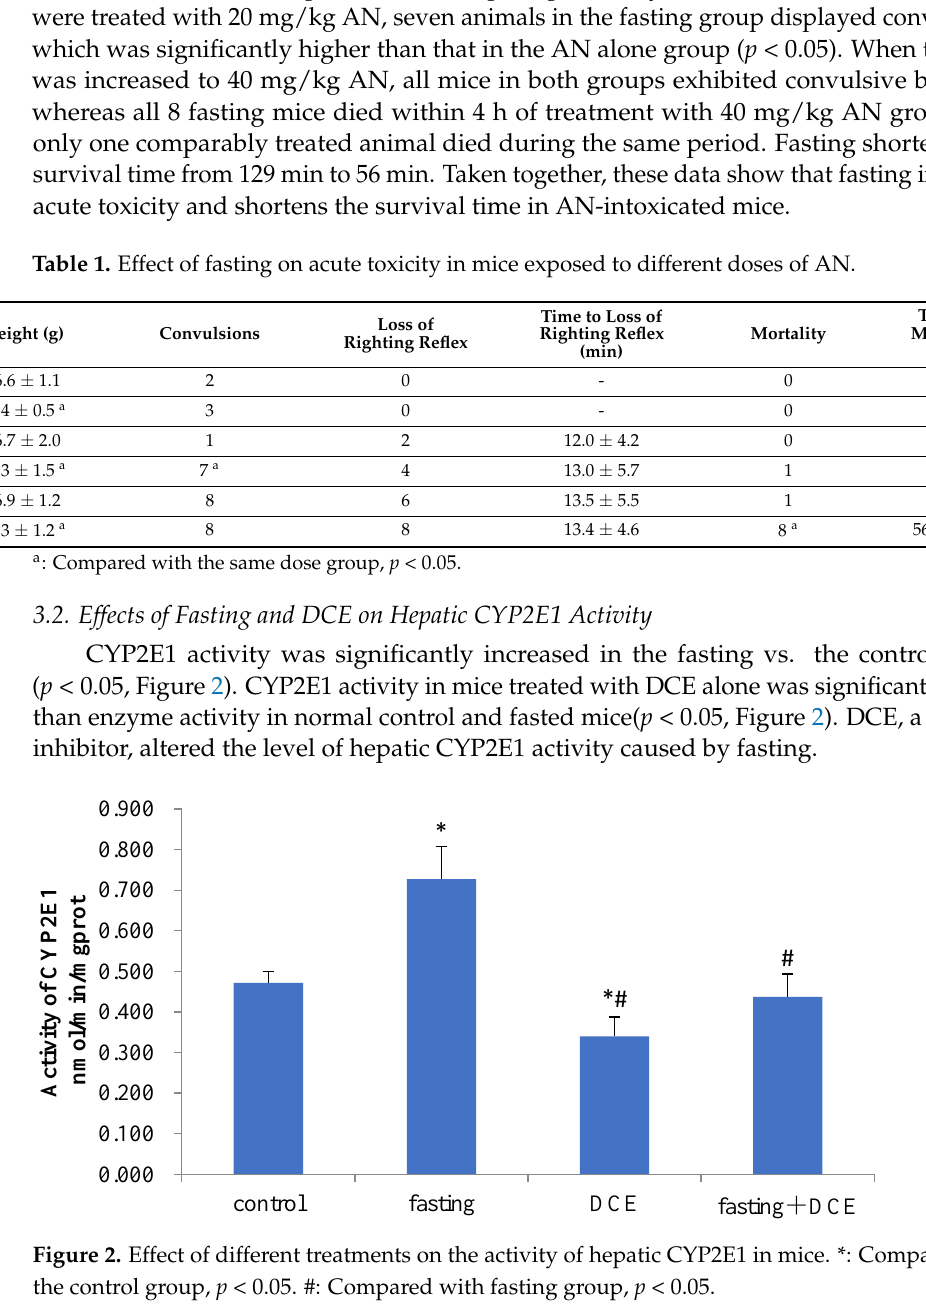
Table2. Effects of fasting and DCE on acute toxicity in mice exposed to 40 mg/kg AN.